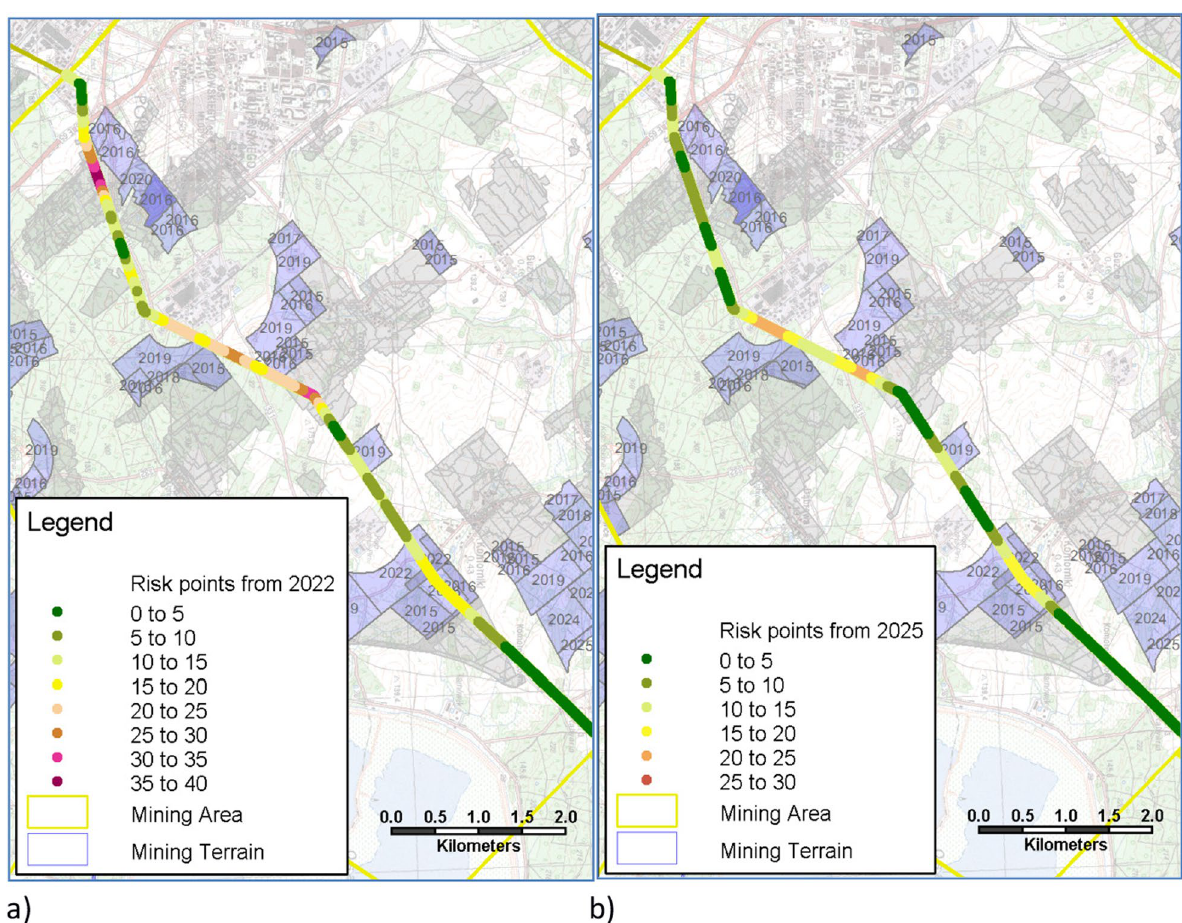
Fig. 8 Time-and-space risk analysis of pipelines with fuzzy model after 2022 ( a ) and after 2025 ( b )